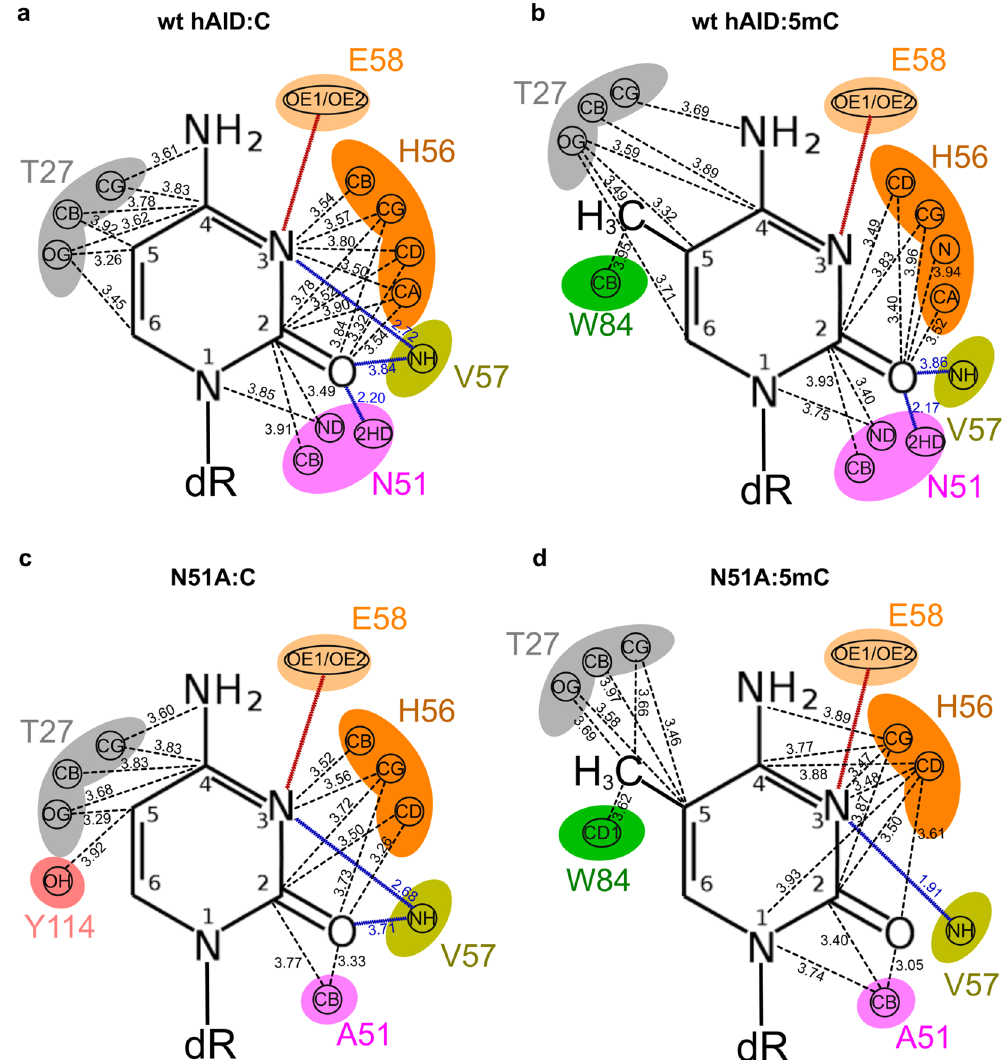
Figure 5. Networks of interactions between C/5 mC pyrimidine rings and wt hAID/N51A mutant catalytic pockets within the four enzyme:substrate complexes: ( a ) wt hAID:C, ( b ) wt hAID:5 mC, ( c ) N51A:C, and ( d ) N51A:5 mC. Different colors represent individual amino acid residues that form catalytic pockets of the tested enzymes. Atoms involved in the particular interactions with the substrate are indicated. VdW interactions are marked by dashed lines. H-bonds are marked by blue lines. The red line represents a hypothetical H-bond whose existence is determined based on the postulated mechanism of the deamination reaction. The distances between interacting atoms are expressed in Å as mean values from the distances measured for all individual frames of the MD